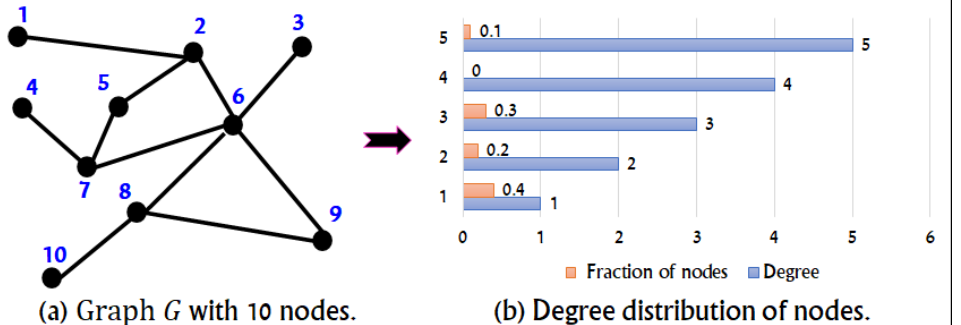
Figure 16. Overview of degree computation from G by privacy-aware graph computing methods.